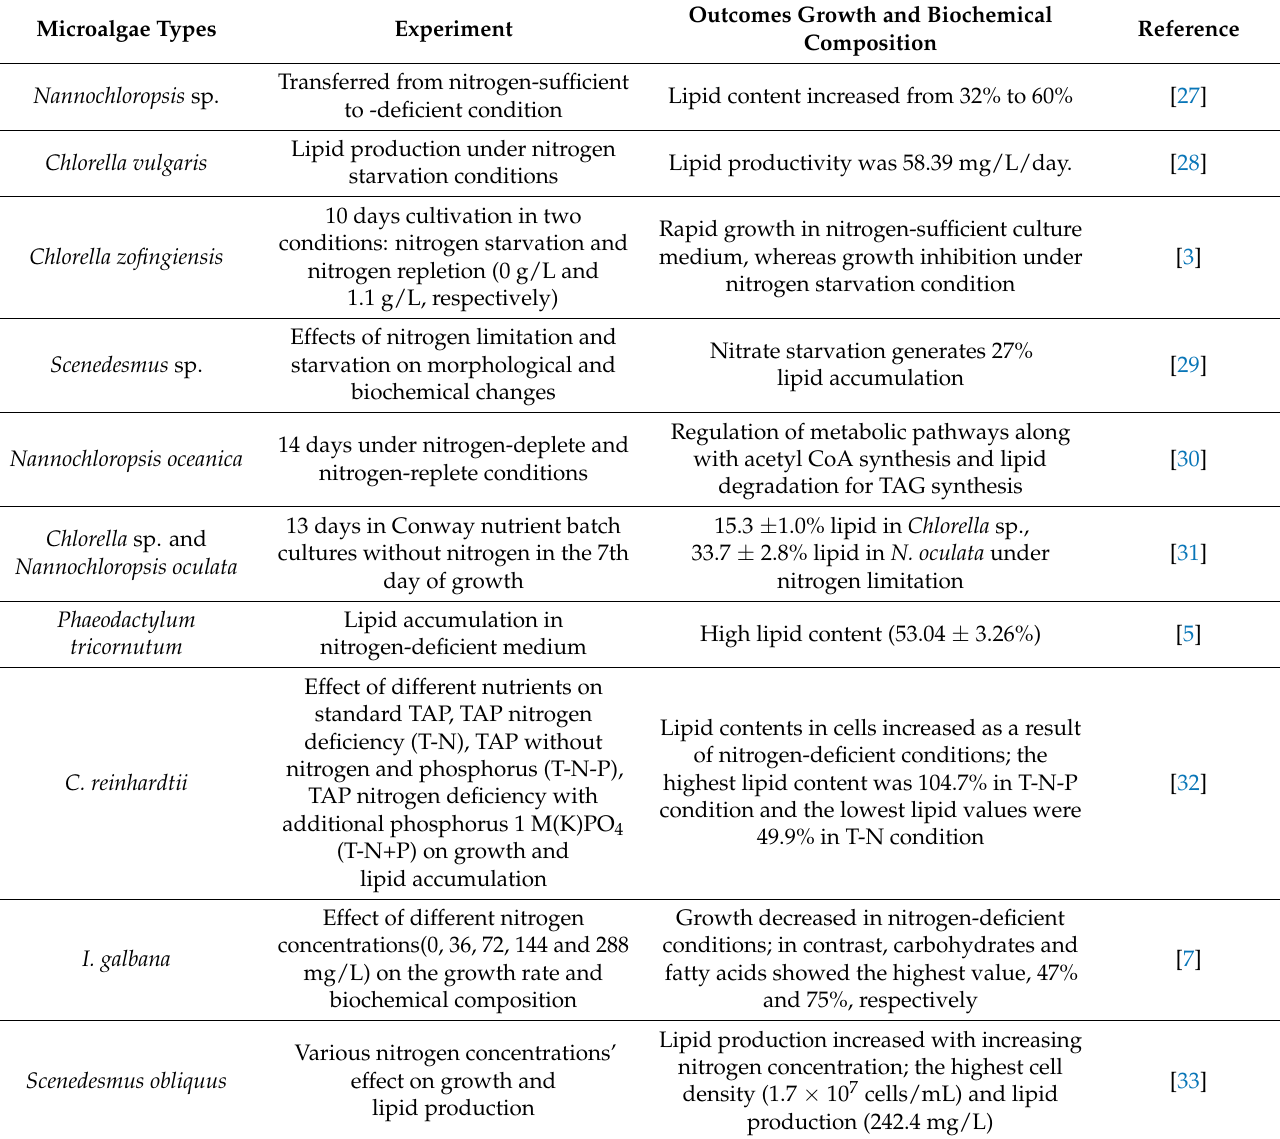
Table 1. Microalgae cultivation correlation with nitrogen